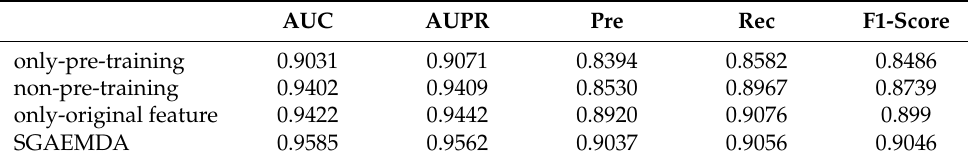
Figure 5. Comparison of the prediction effect of different models. Table 2. Comparison table of each evaluation metric for different